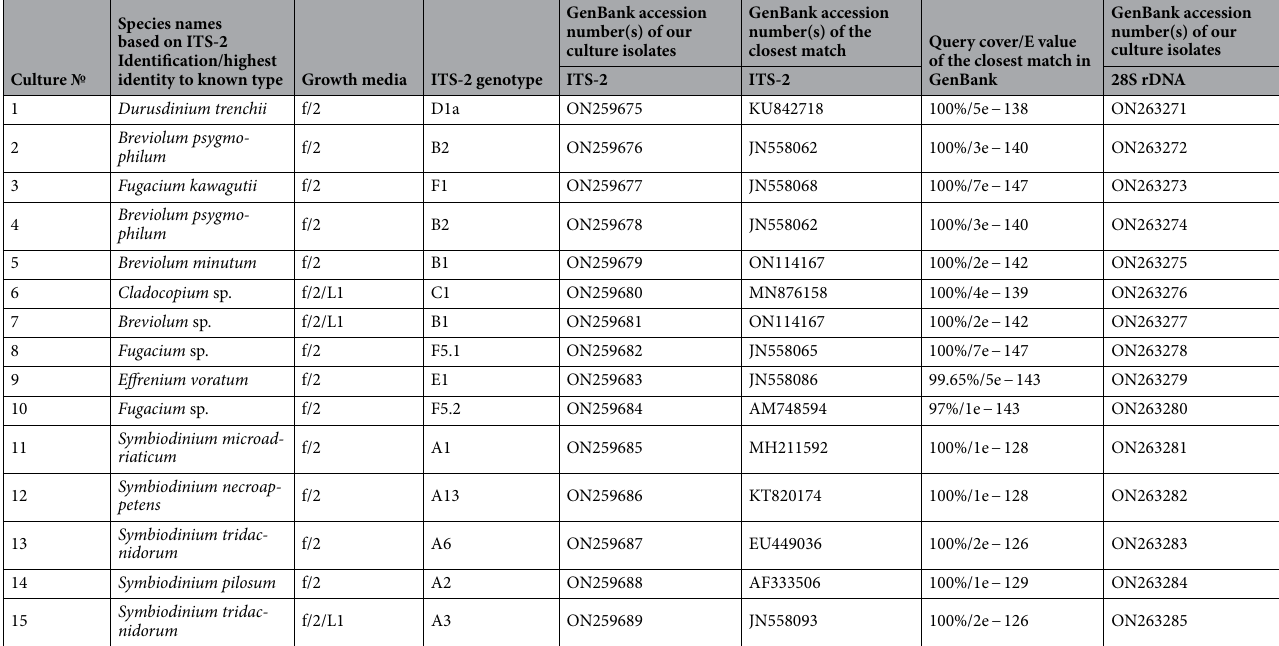
Table 1. Fifteen culture isolates representing 13 distinct putative species from six genera in the family Symbiodiniaceae and their ITS-2 ribosomal RNA (rRNA) genotypes. The culture isolates were grown in both f/2 and f/2/L1 media and the GenBank accession numbers of both ITS-2 and 28S rRNA gene sequences are provided. The GenBank accession numbers of the species that is the closest match and its query cover/E value in Nucleotide BLAST are